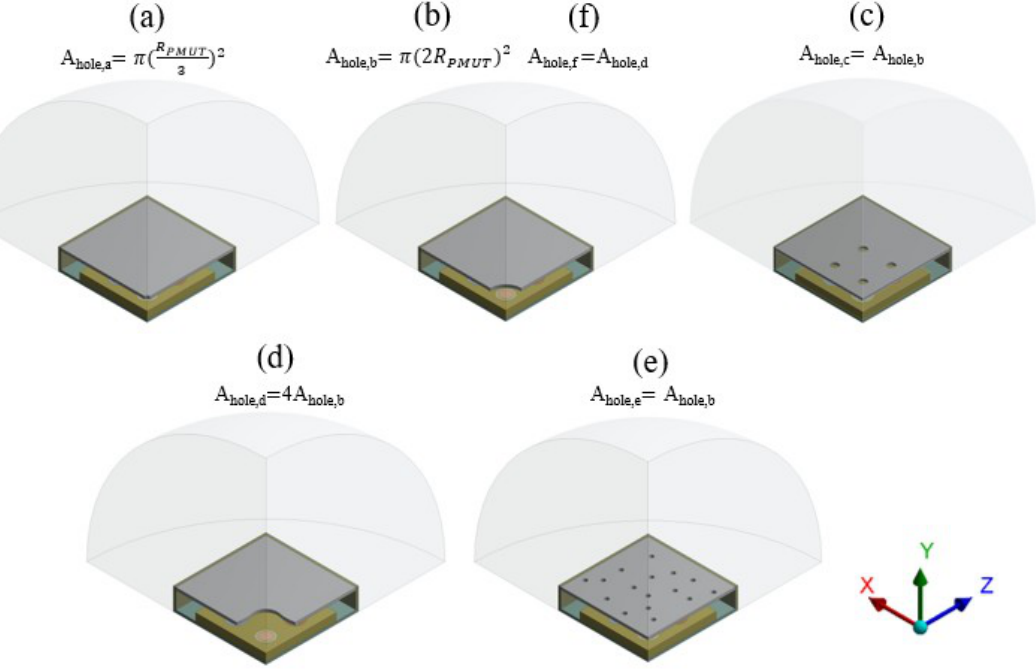
Figure 17. Different cap geometries as described in the main